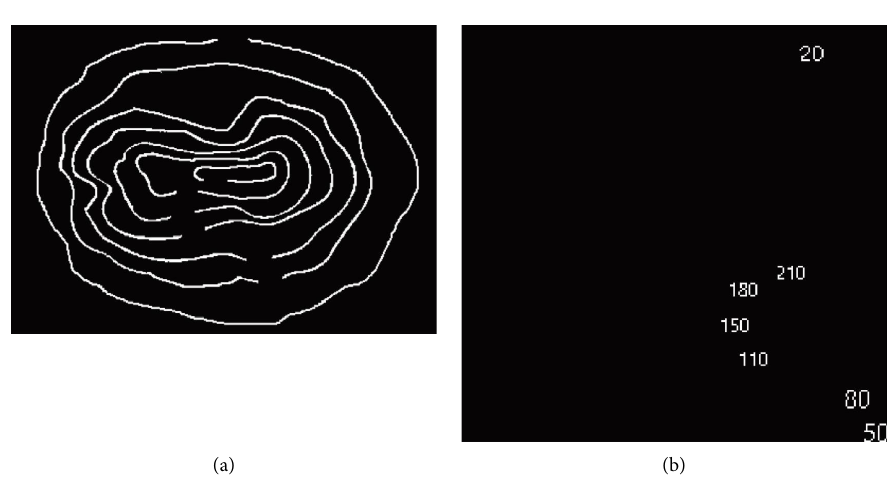
Figure 3: Demonstration of the connected domain segmentation technology: (a) curves and (b) numbers.